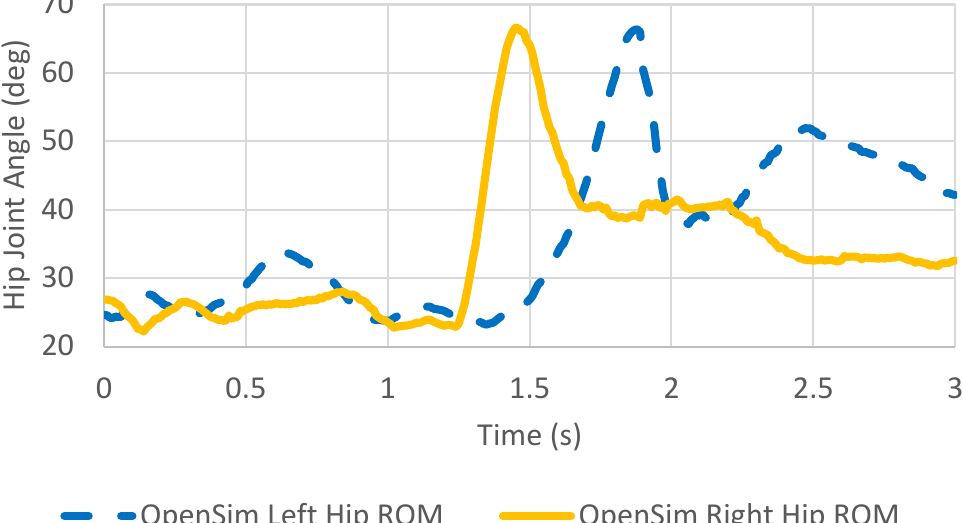
Figure 3. Hip joint ROM for left and right hips over a 3 s period.